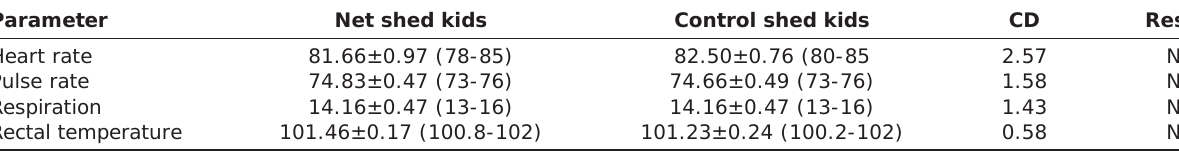
Table-10: Physiological parameters in kids under net and control shed.